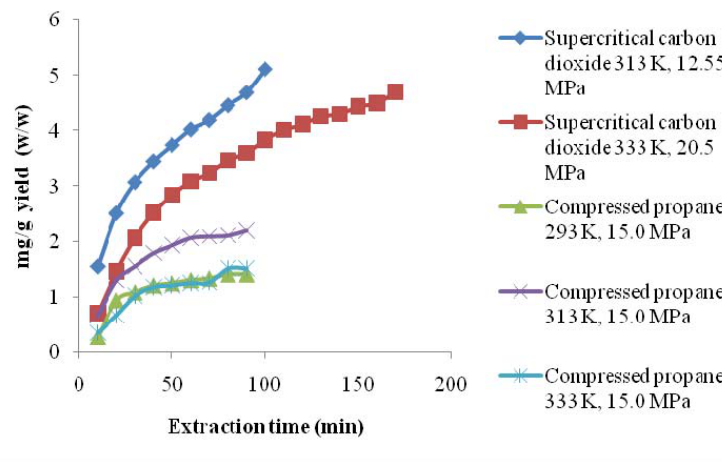
Figure 3. The cummulative yield of compound 1 , with respect to extraction time, using supercritical CO and compressed 2